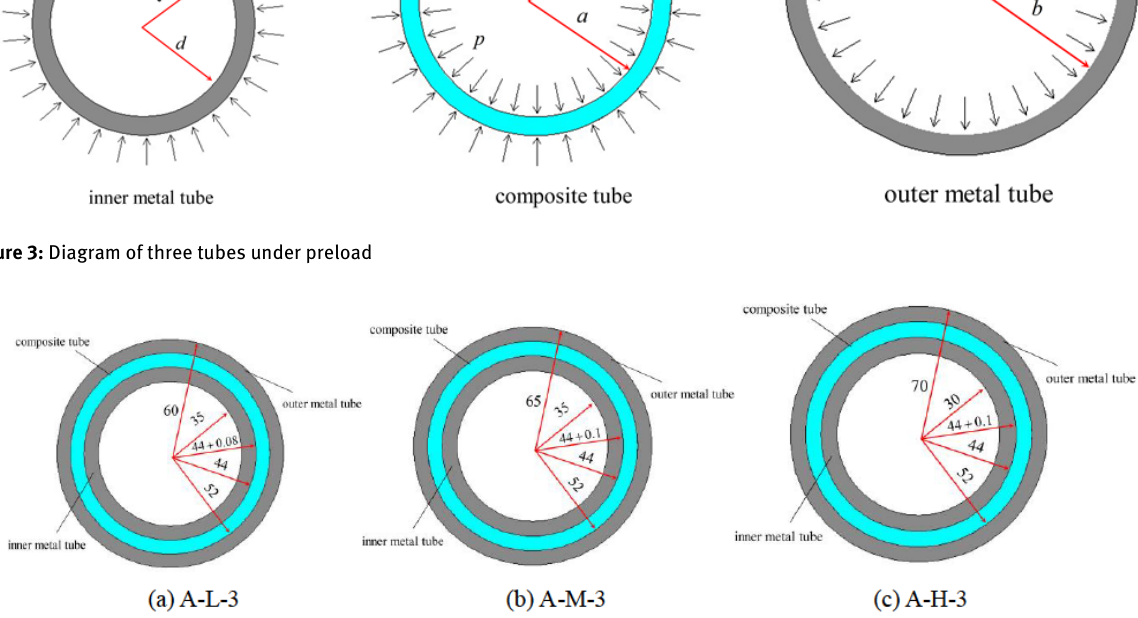
Figure 4: Geometry of the composite pre-tightening force tooth connection